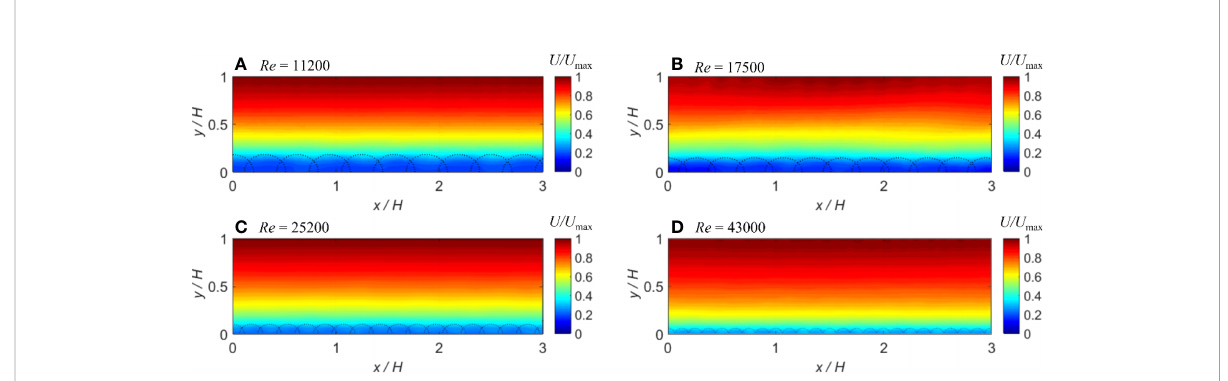
FIGURE 2 (A – D) Longitudinal contours of computed time-averaged streamwise velocities at the fl ume centerline for different fl ow conditions. The dashed semicircles at the bottom of each panel represent the rough bed